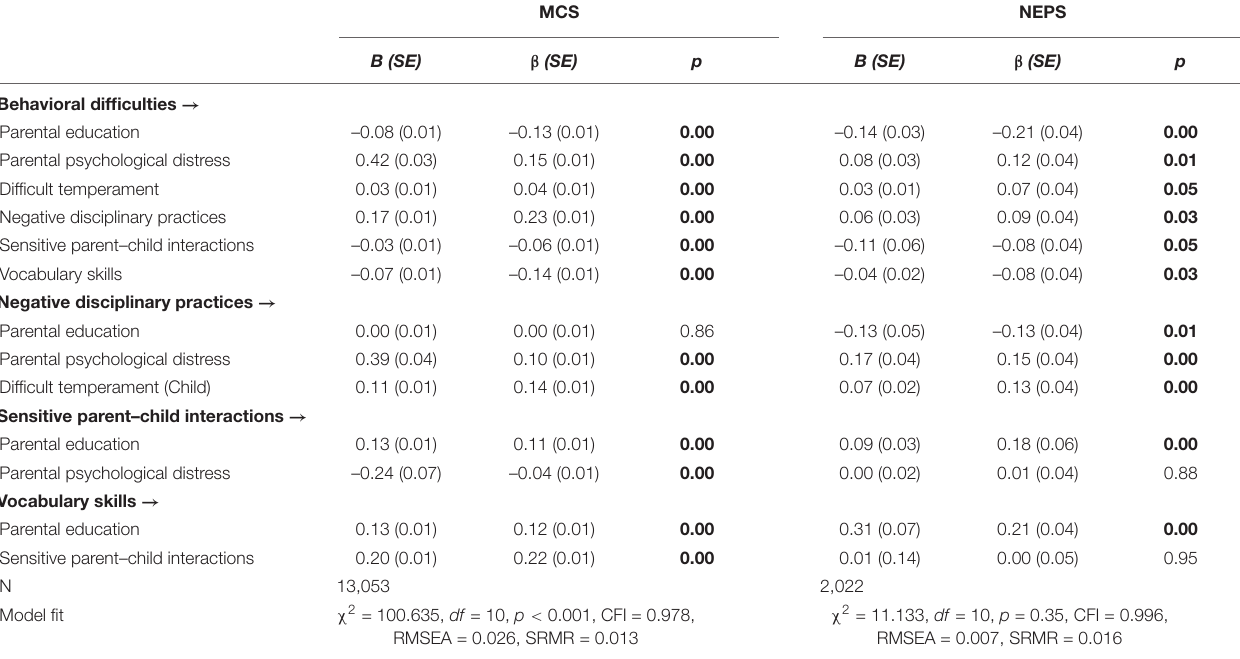
TABLE 3 | Results from structural equation modeling for MCS and